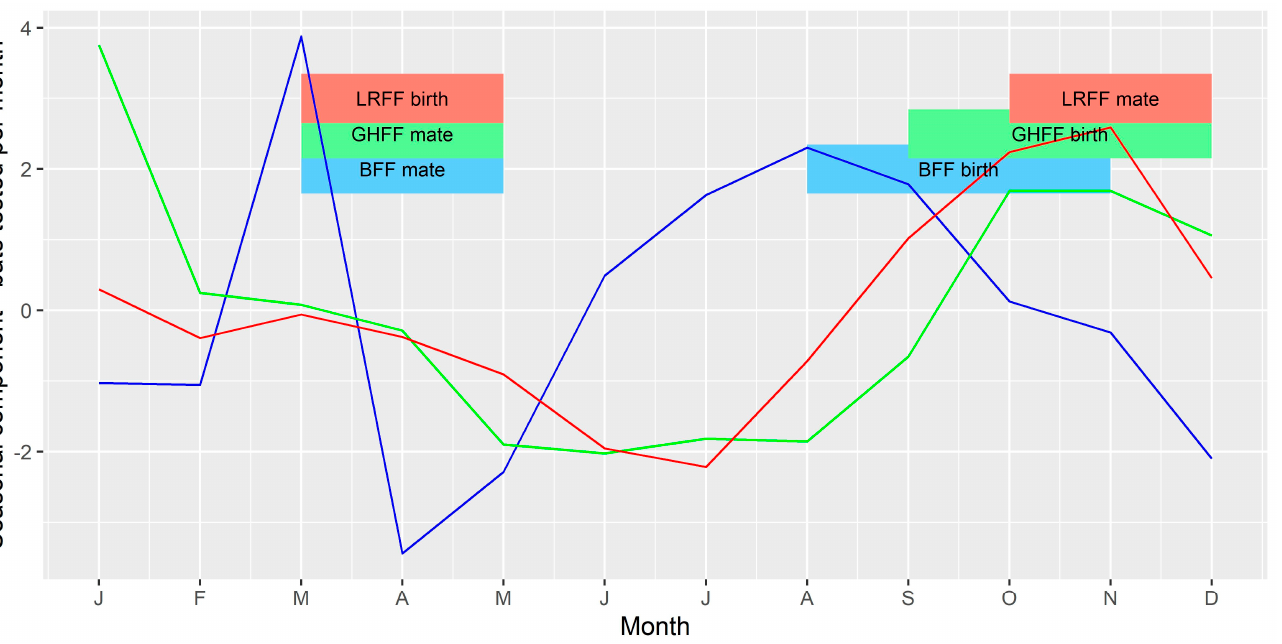
Figure 8. Seasonal component of time series of ABLV prevalence per month. The vertical axis represents the expected increase or decrease in prevalence (as a proportion) in each month. Blue = BFF; green = GHFF; red = LRFF. 4. Discussion